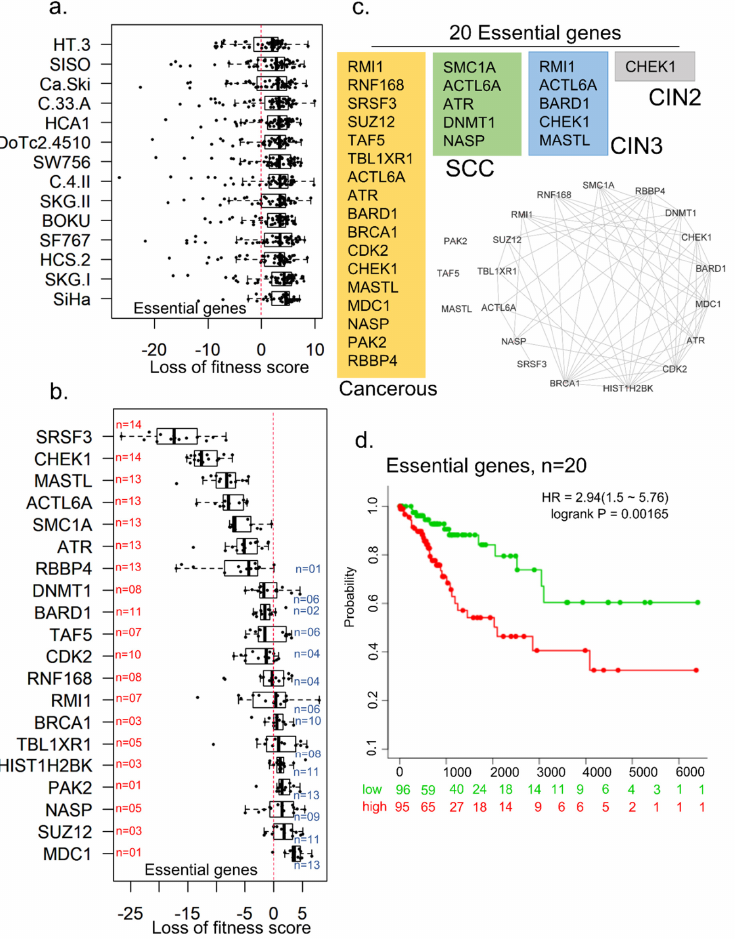
Figure 5. Role of epigenomic and chromatin regulators as fitness targets. ( a ) Fitness dependency distribution of 57 test regulators in cervical cancer cell lines. ( b ) Twenty essential genes cause loss of function on depletion in cervical cancer cell lines. The red and blue numbers represent the number of dependent and not dependent cell lines for each gene, respec- tively. ( c ) Protein–protein interaction network and expression classification of 20 essential epigenomic regulators. ( d ) Kaplan–Meier curves for 20 essential genes. Red and green color represents high and low-risk patients, respectively ( n = 191). The X-axis represents survival days. Numbers below the axis represent the number of patients not facing an event over time for each group.